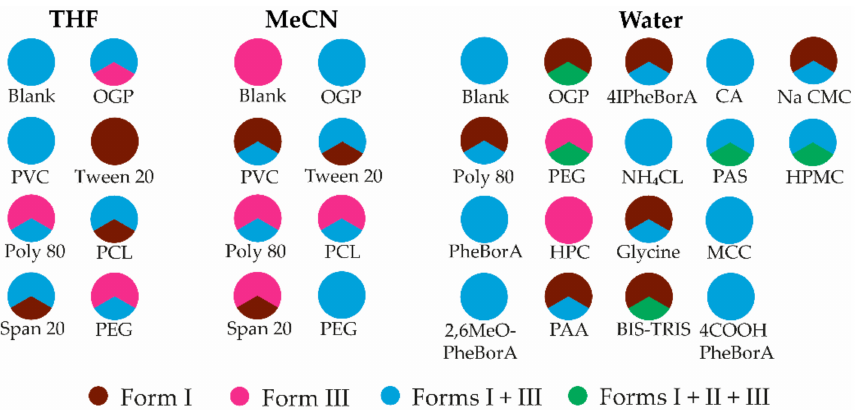
Figure 6. Polymorphic outcome of crystallization experiments in the presence of additives from THF, MeCN, and water. Each 1/3 of the pie chart represents one of the parallel